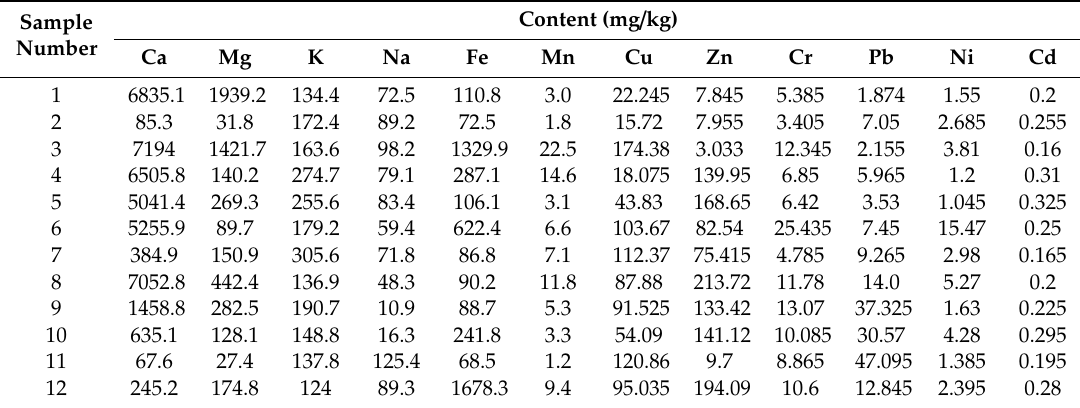
Table 2. Contents of the analysed metals in samples before